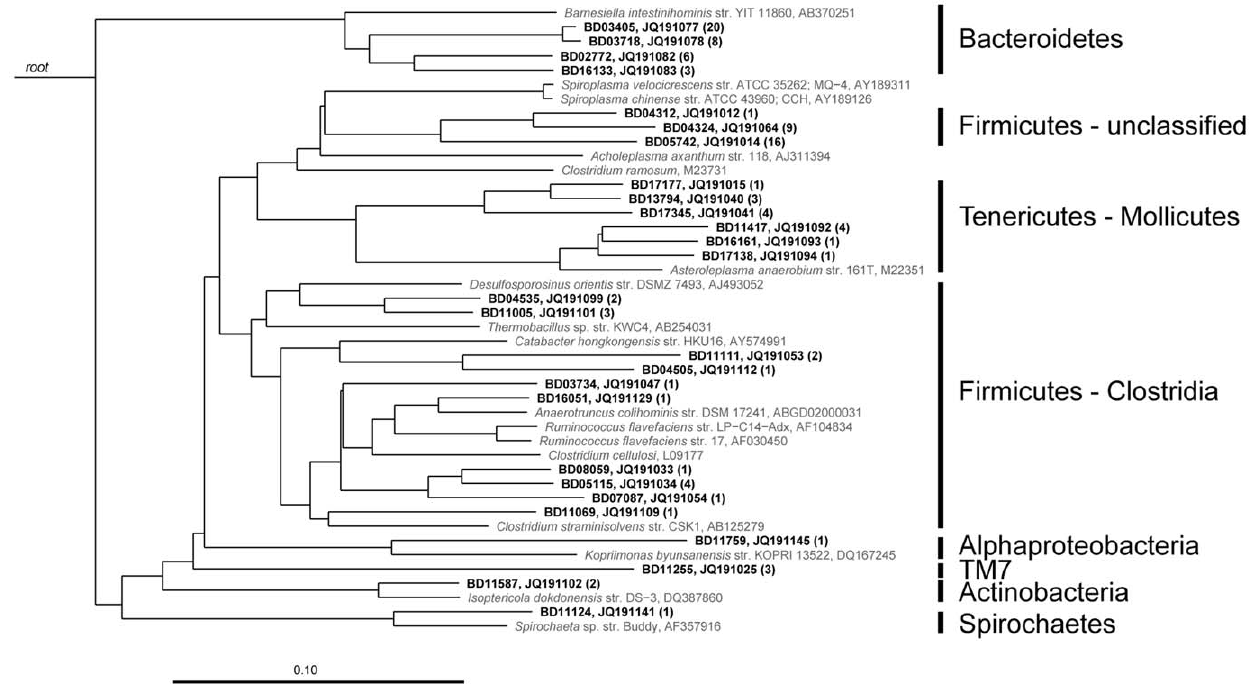
Figure 7. Phylogeny of the most novel OTUs found in the distal gut microbiota of children from Bangladesh. Neighbor joining tree based on near full-length 16S rDNA sequences showing the 27 OTU representatives (in bold) from the Bangladesh dataset that have less than 95% sequence similarity to published sequences, and their Genbank accession numbers. The tree was rooted with the archaeal 16S ribosomal RNA gene from Halococcus morrhuae (X00662). The number of clones for each OTU in the near full-length dataset is shown in parentheses. Their closest